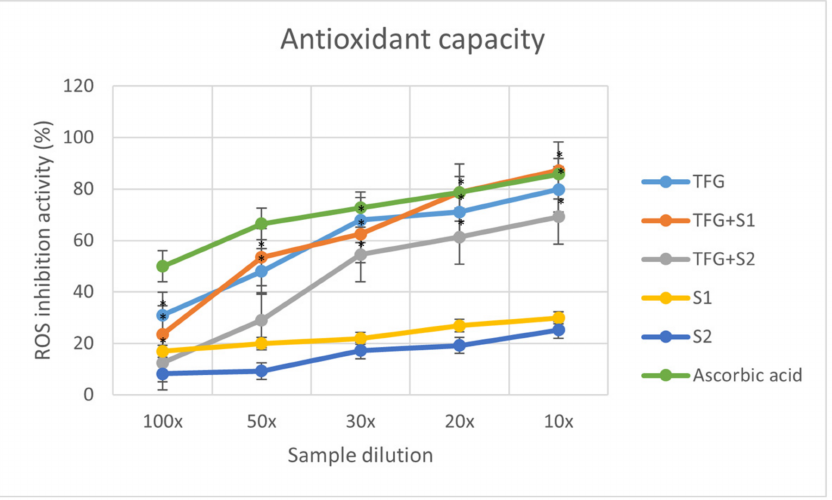
Figure 3. Antioxidant capacity of the 5 compositions and ascorbic acid, as a positive control. Each data point represents the mean ± S.D. of 3 experiments, with * p < 0.05 compared with the control.